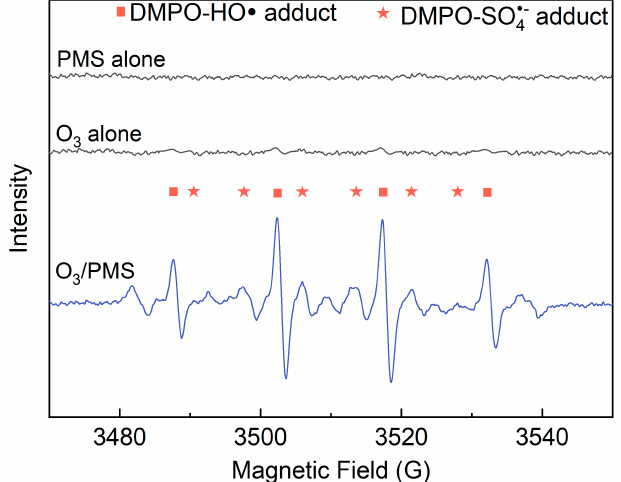
Figure 4. Derivative electron paramagnetic resonance (EPR) spectra of samples collected from PMS alone, O 3 alone, and O 3 / PMS systems. Conditions: [PMS] 0 = 0.4 mM; [DMPO] 0 = 1.0 g · L − 1 ; [O 3 ] 0 = 41.7 µ M (2 mg · L − 1 ); pH = 7.4; 15 ± 1 °C).